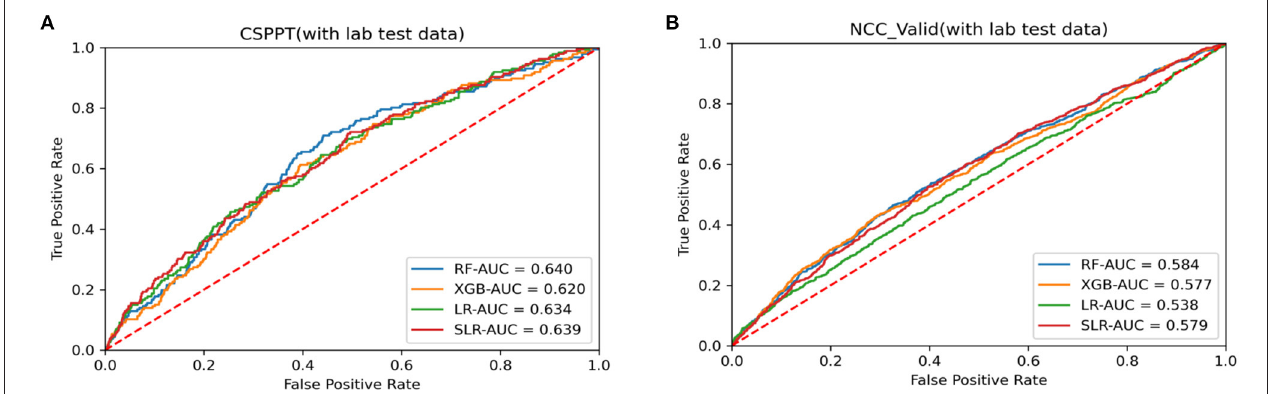
FIGURE 2 | Receiver operating characteristic (ROC) curves for data analysis methods with laboratory data in (A) CSPPT dataset (training set) and (B) NCC dataset (external validation set).